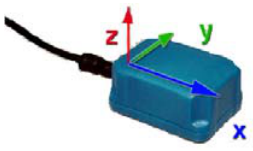
Figure 2. The inertia sensor (MTx).